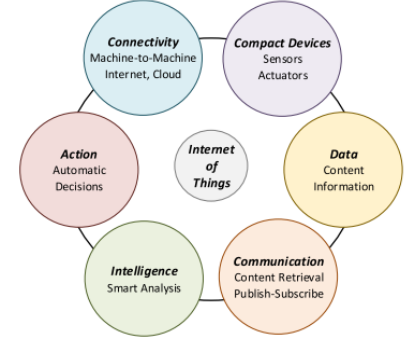
Figure 1. IoT Features & Advantages